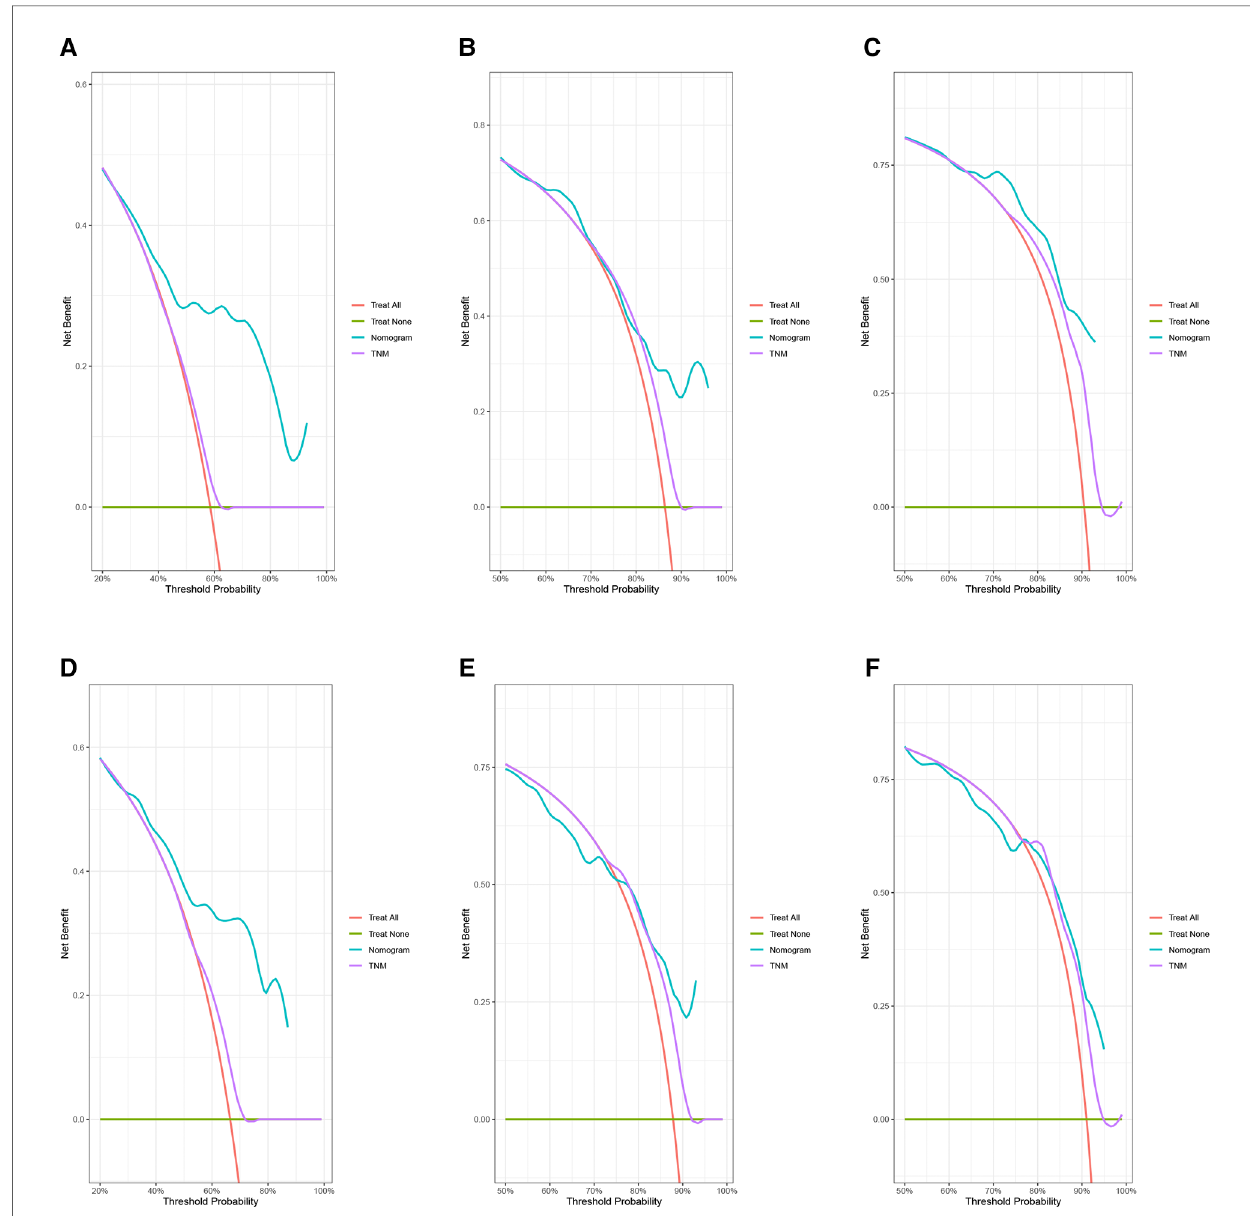
FIGURE 6 DCA curves of the 1-, 3-, and 5-year OS of NEPC patients. 1-year ( A ), 3-year ( B ), 5-year ( C ) OS in training group; 1-year ( D ), 3-year ( E ), 5-year ( F ) OS in validation